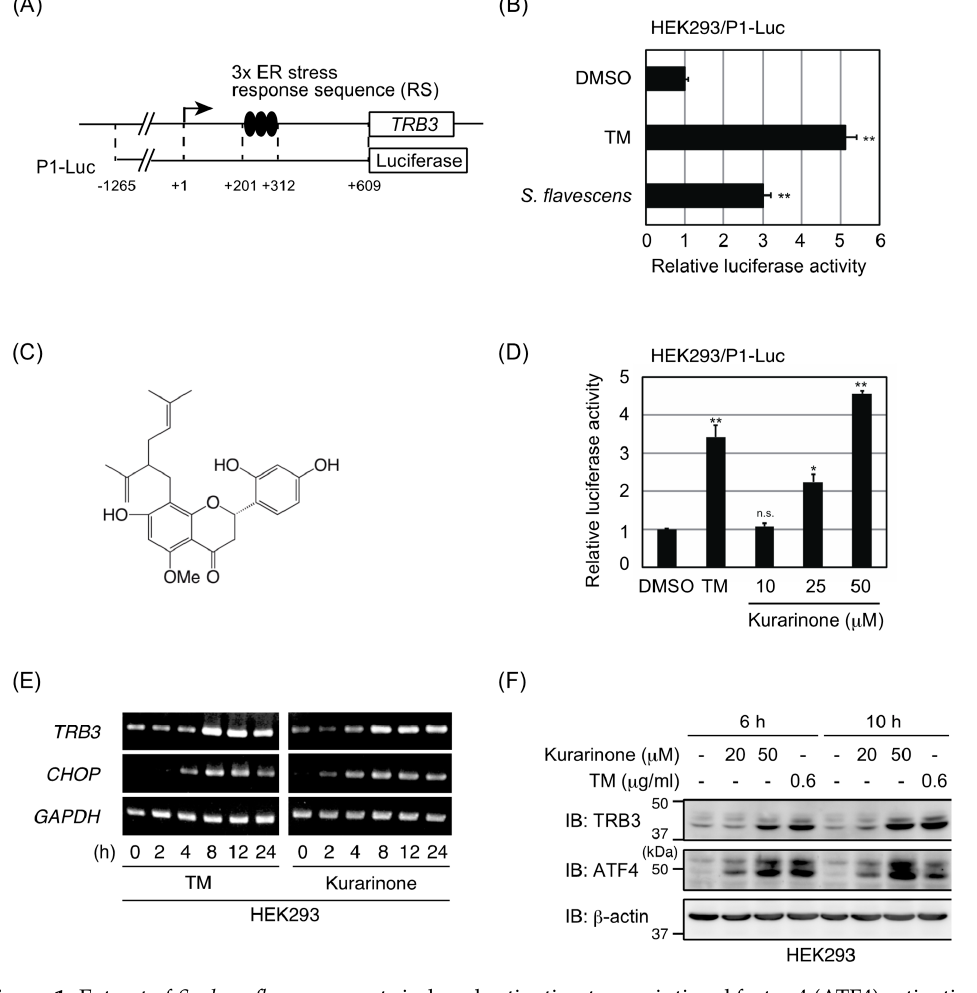
Figure 1. Extract of Sophora flavescens roots induced activating transcriptional factor 4 (ATF4) activation. ( A ) A schematic diagram of the human TRB3 promoter plasmid. ( B ) HEK293 / P1-Luc reporter cells were incubated with 2 µ g / mL of tunicamycin (TM) or 100 µ g / mL of the extract (ex.) of S. flavescens roots. After 24 h, luciferase activities were measured. Data represent the mean fold activation ± S.D. ( n = 3). ( C ) Structure of kurarinone. ( D ) HEK293 / P1-Luc reporter cells were incubated with 0.6 µ g / mL of TM or the indicated doses of kurarinone. After 24 h, luciferase activities were measured as in ( A ). Data represent the mean fold activation ± S.D. ( n = 3). ( E ) HEK293 cells were treated with 0.6 µ g / mL of TM or 50 µ M of kurarinone for the indicated times. The expression level of each gene was assessed by semiquantitative PCR. ( F ) HEK293 cells were incubated with the indicated doses of TM or kurarinone for the indicated periods. The level of the indicated proteins was determined by immunoblotting. Significant di ff erences are indicated as ** p < 0.01. * p < 0.05. n.s.: not